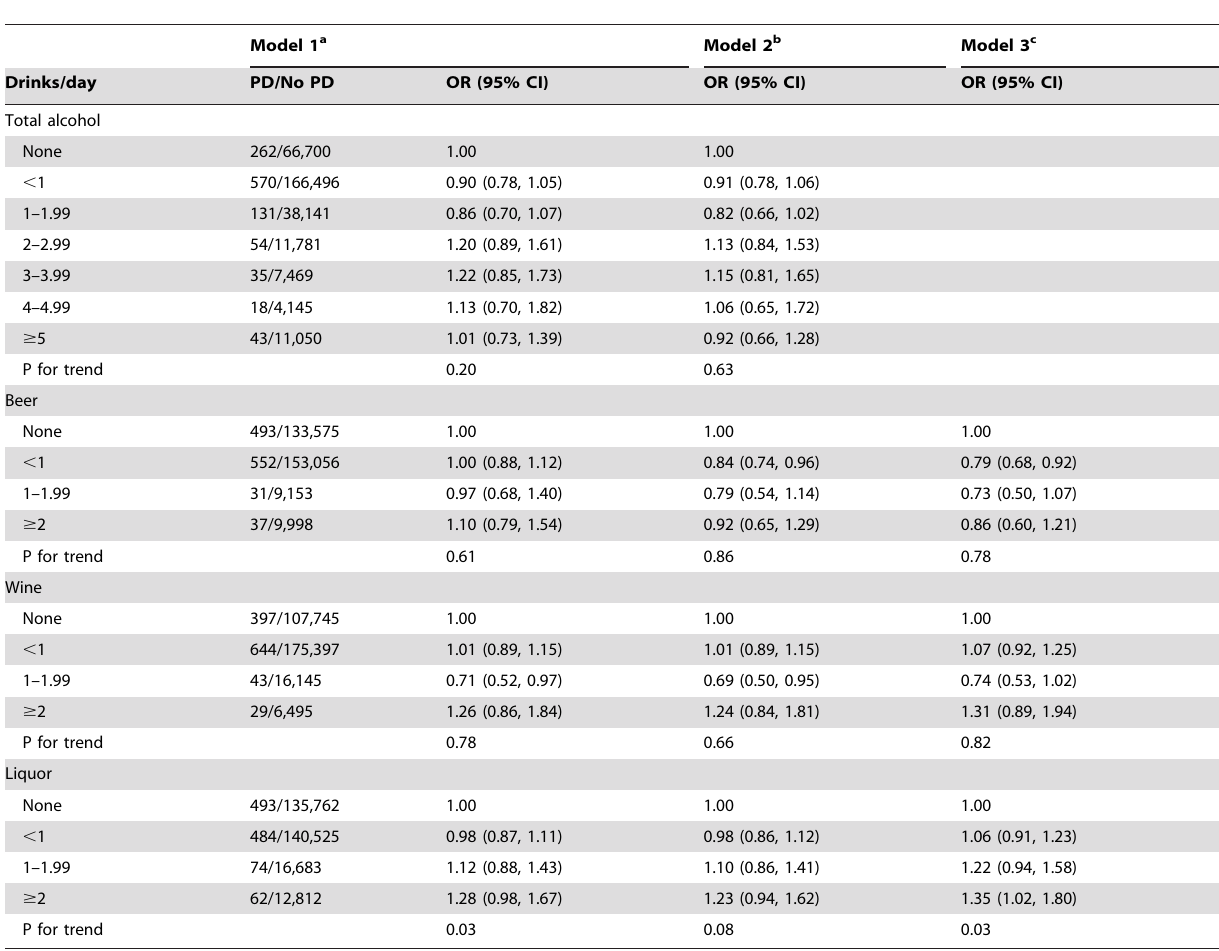
Table 2. Odds Ratios of Parkinson’s Disease According to Consumption of Total Alcohol and Specific Types of Alcoholic Beverages, NIH-AARP Diet and Health Study, 1995–2006.